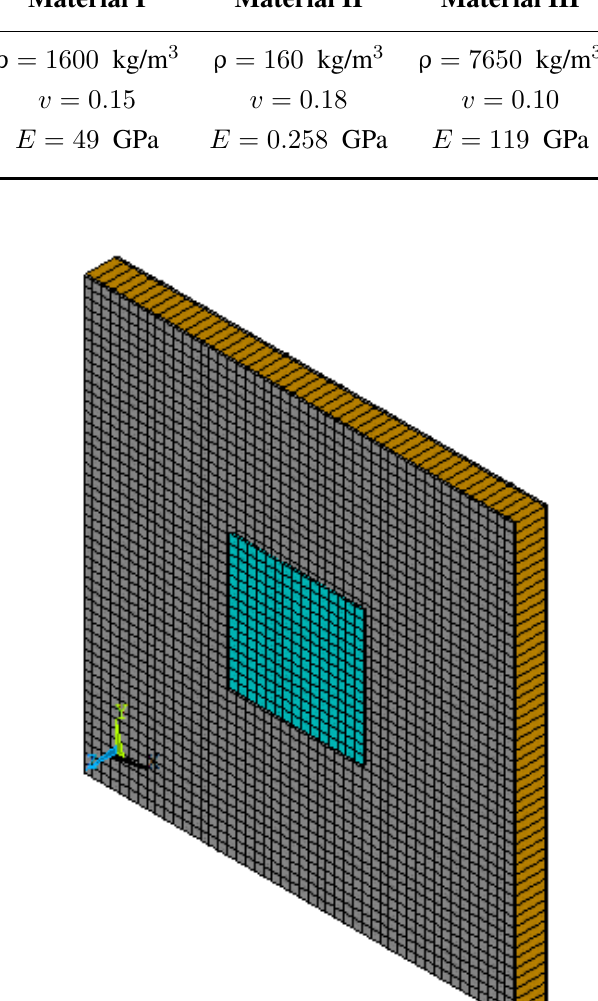
Figure 2. A discretised periodic segment of the modelled sandwich panel with a piezoelectric patch attached to